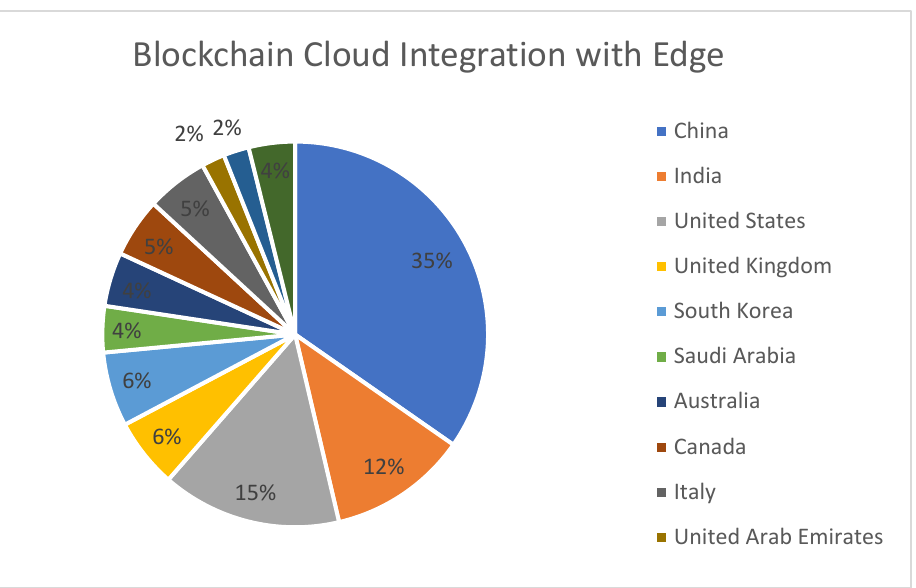
Figure 18. Region-specific publication distribution for Blockchain–Cloud integration with IoT. Figure 19 represents the region-wise publication distribution for works concerning the use of Blockchain–Cloud integration along with Edge computing. China is the most prominent region with the highest number of contributions.